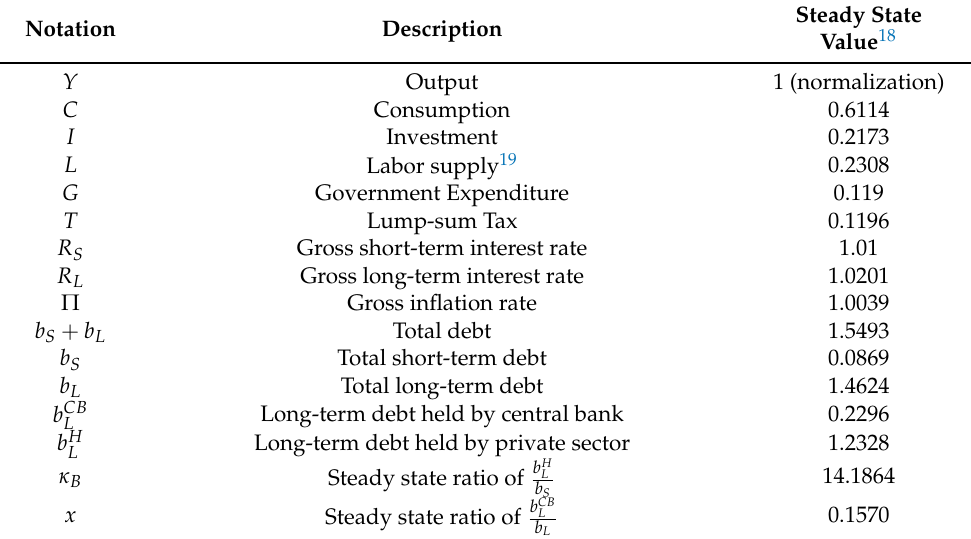
Table 1. Calibration for steady